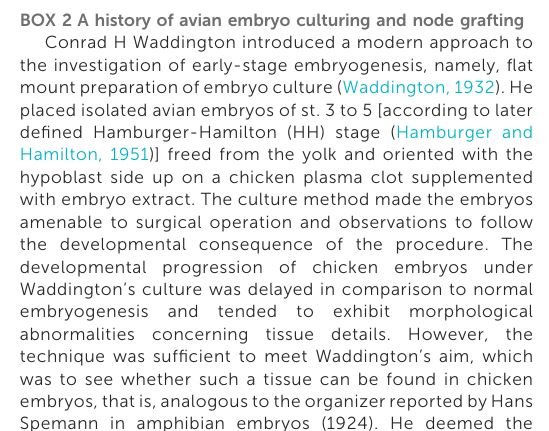
(whether in the anterior or posterior half of the embryo) (Figure 4A). The anterior and posterior embryonic regions are separated at the axial level corresponding to the posterior limit of the brain precursors approximately 300 µm posterior to the anterior end of the node (Figure 4). The node in the original position develops into an anterior extension of the AME at the beginning of st. 5 and into a posterior extension of the posterior notochord (PNC) at the end of st. 5 (Figure 4Aa). Thus, the grafting of the mCherry-labeled node in the node position allowed the development of both anterior and posterior components. Grafting the node in an anterior embryonic position outside the node caused only the AME extension that occurred synchronously with the host AME (Figure 4Ab). Under this condition, the secondary head tissue developed (Figure 4B, upper panel), as detailed below. In contrast, when the node graft was placed at a posterior level, it developed only PNC synchronously with the host PNC (Figure 4Ac), without accompanying development of